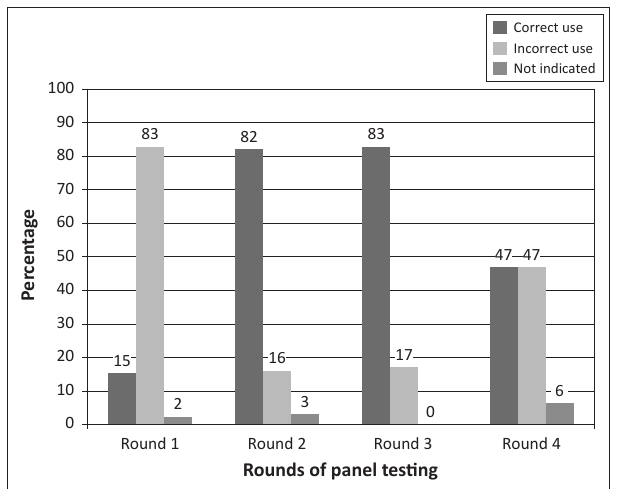
FIGURE 2: Use of national testing algorithm in HIV diagnosis.